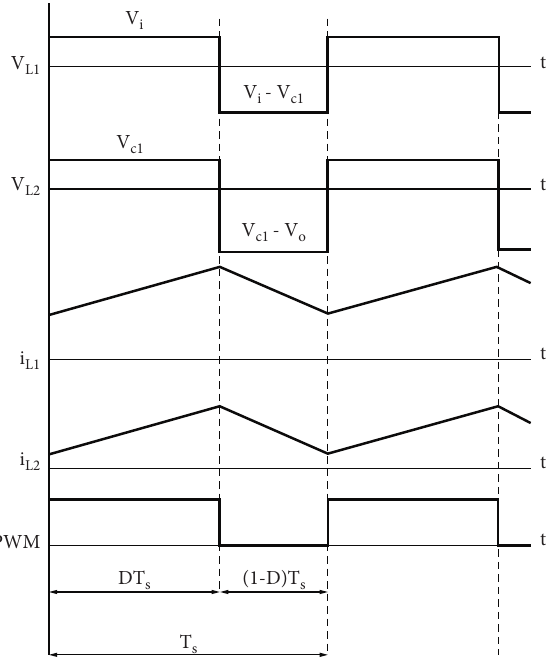
Figure 5: Converter’s buck mode operation, mode 2.